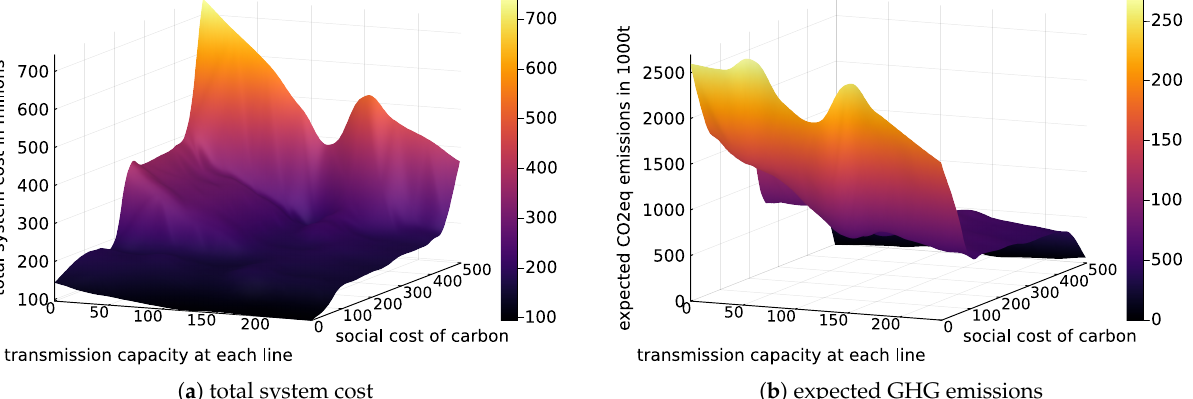
Figure 7. ( a ) shows the total system cost in millions of $US with respect to both the valuation of GHG emissions and the transmission line capacity; ( b ) shows the CO 2 eq emissions for the same observation